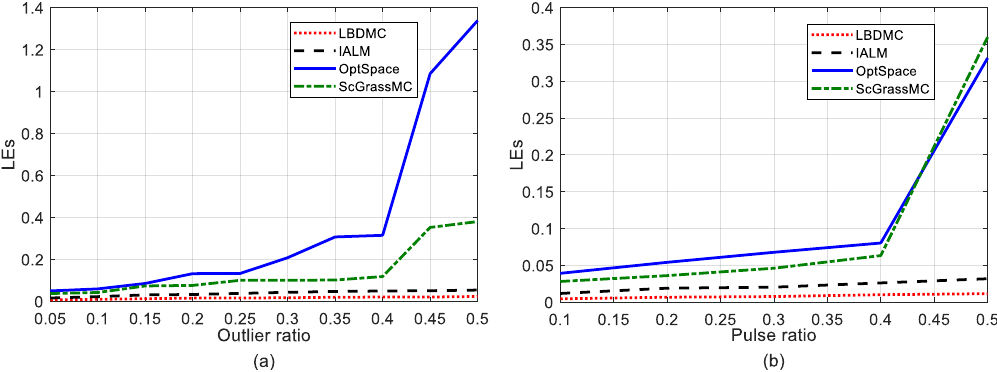
Figure 8. Mean localization error versus different noise levels. The sampling rate is fixed at 50%. The outlier ratio varies successively from 5 to 50%. The pulse ratio varies successively from 10 to 50%. The sampling rate is fixed at 50%: ( a ) Mean localization error versus different outlier ratios; ( b ) Mean localization error versus different pulse ratios.